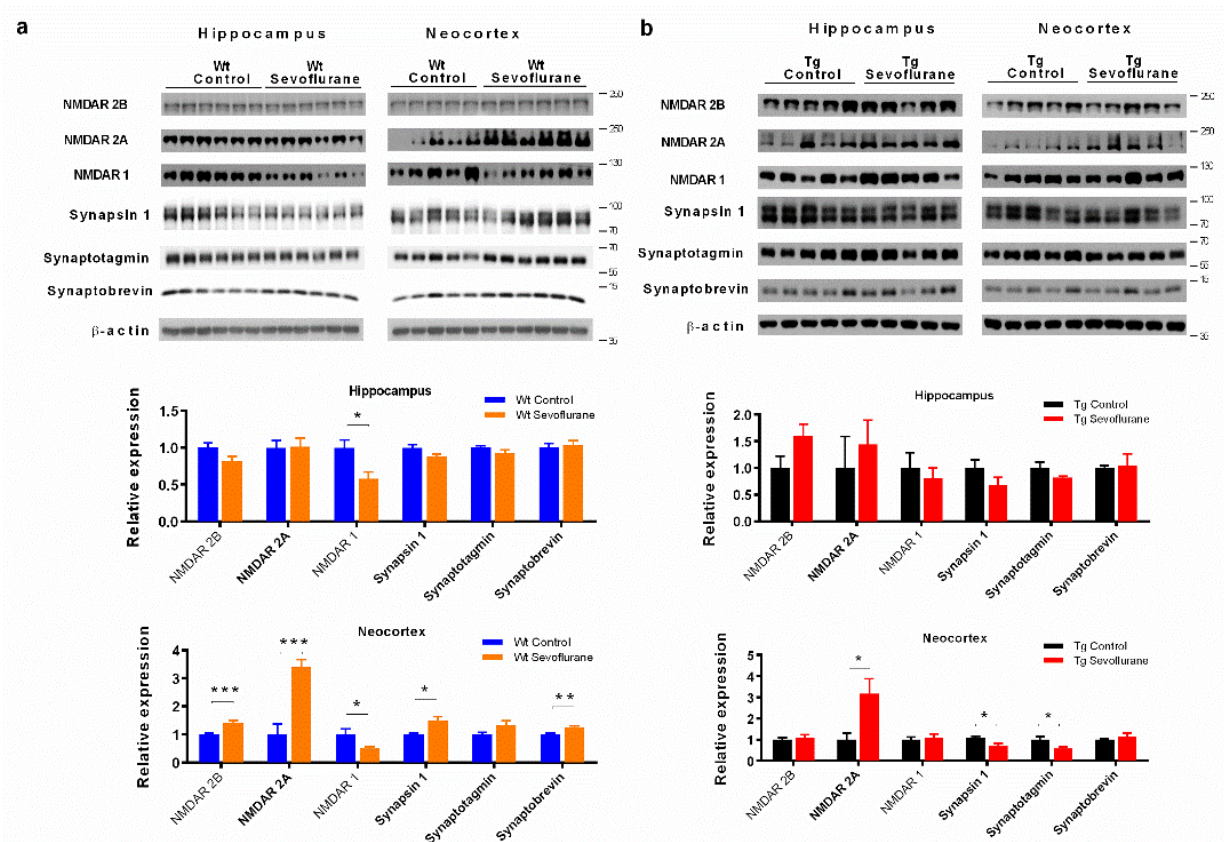
Figure 2. Sevoflurane altered NMDA receptors and synaptic protein expression in the hippocampus and neocortex. Synaptic NMDA receptors and vesicle proteins in hippocampus and neocortex of ( a ) wild-type mice and ( b ) 3 × Tg mice after sevoflurane exposure. Statistic graphs below show the quantification of Western blot. Data correspond to the mean ± SEM ( n = 5 – 6) and represent the band densities that were normalized with the endogenous loading control. * p < 0.05, ** p < 0.01, *** p < 0.001 in comparison to the control. Values were analyzed using the unpaired t -test.